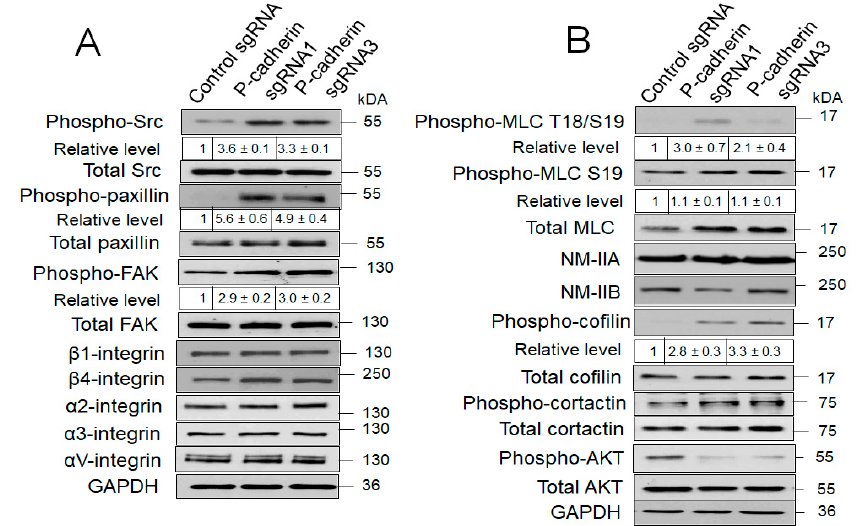
Figure 7. P-cadherin knockout affects matrix adhesion and actin cytoskeleton-related signaling. Immunoblotting analysis of expression and phosphorylation of different proteins involved in cell- matrix adhesion ( A ) and actin cytoskeleton remodeling ( B ) in control and P-cadherin knockout HCA-7 cells.